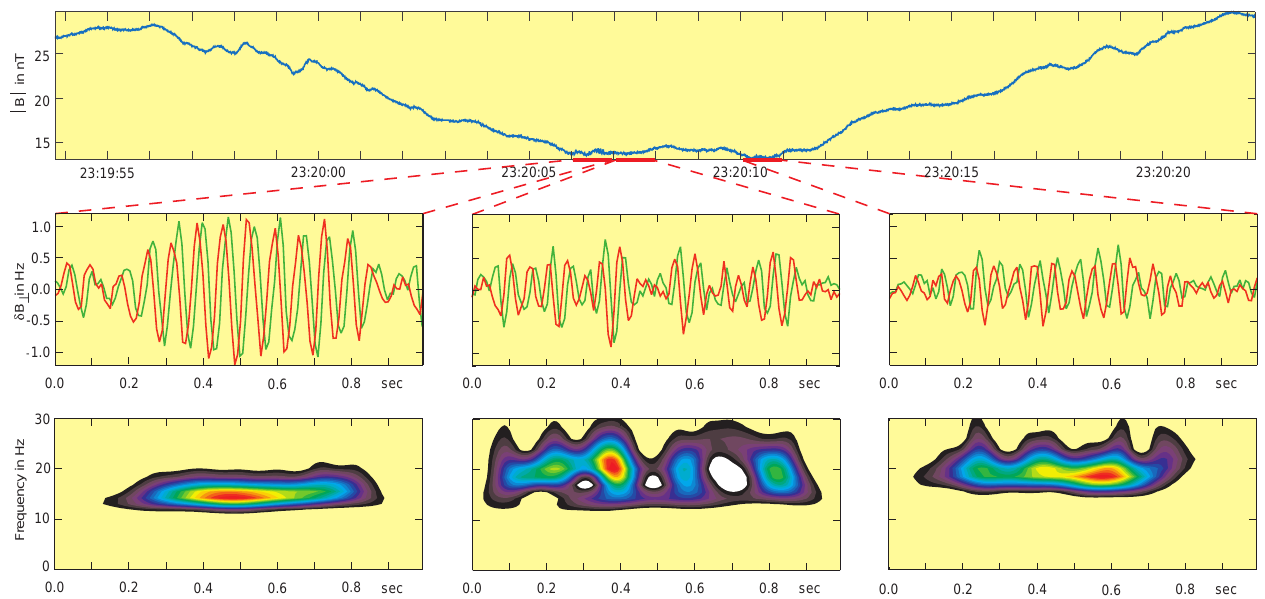
Fig. 1. Mirror mode trough, embedded lion roar wave forms perpendicular to the mean field, and right-hand polarized wavelet